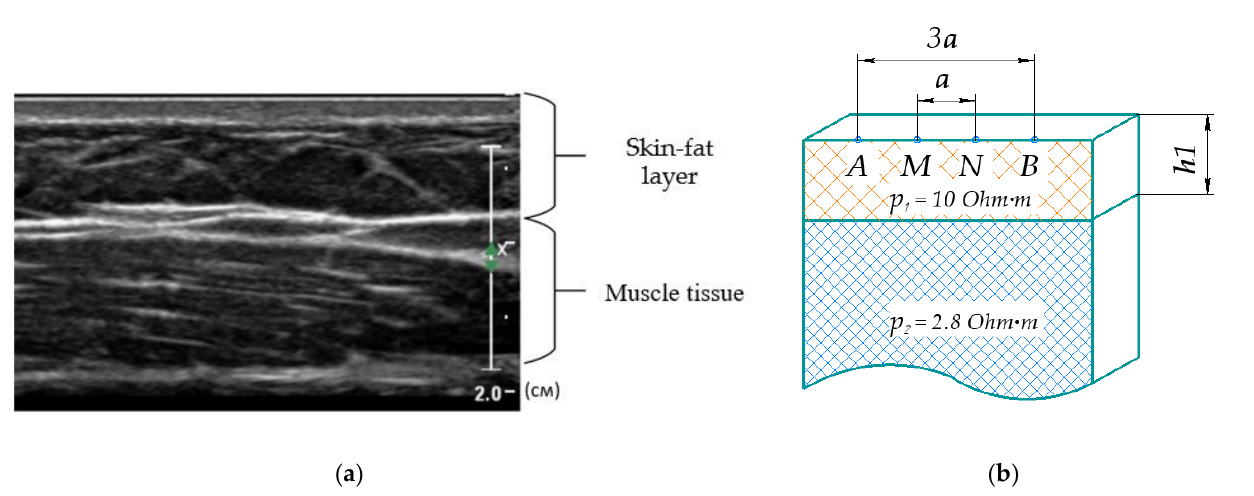
Figure 8. ( a ) Longitudinal forearm ultrasound investigation; ( b ) a homogeneous half-space two-layer model, represented by the skin-fat layer and muscle tissues, A and B—CE, M and N—PE; ρ 1 is the skin-fat layer electrical resistance, ρ 2 is the muscle tissues electrical resistivity, h1 is the skin-fat layer